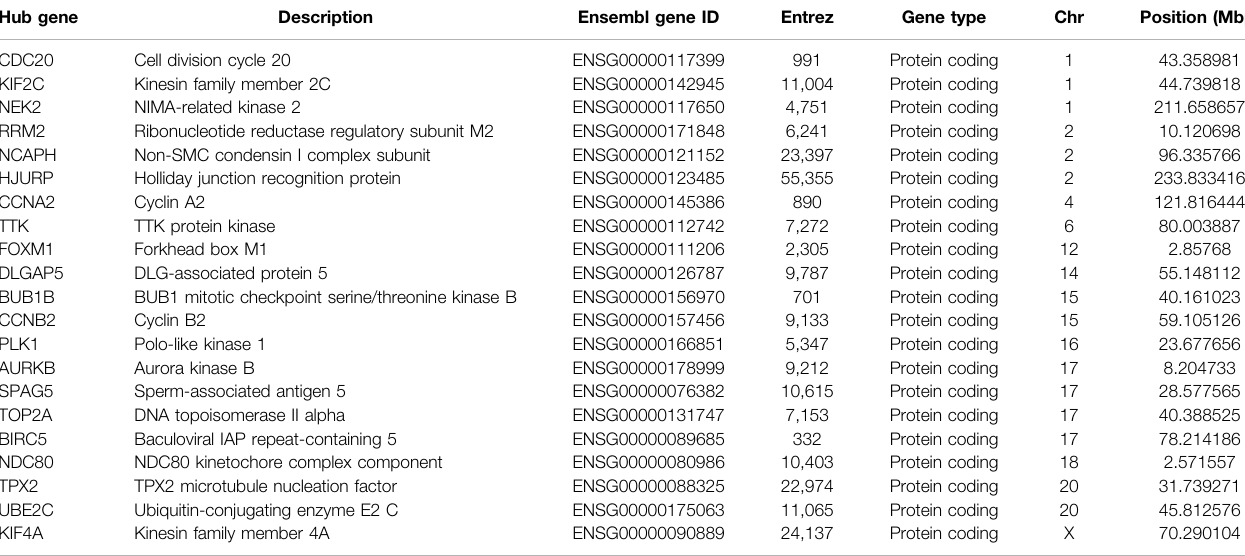
TABLE 3 | COVID-19/NSCLC interactional hub genes. Hub